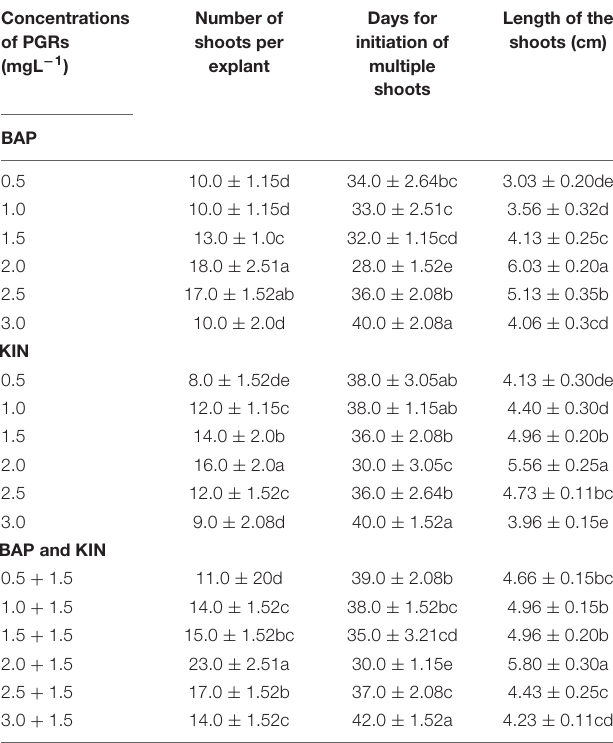
TABLE 2 | In vitro responses of nodal explants of Withania somnifera to different concentrations of PGRs. Concentrations of